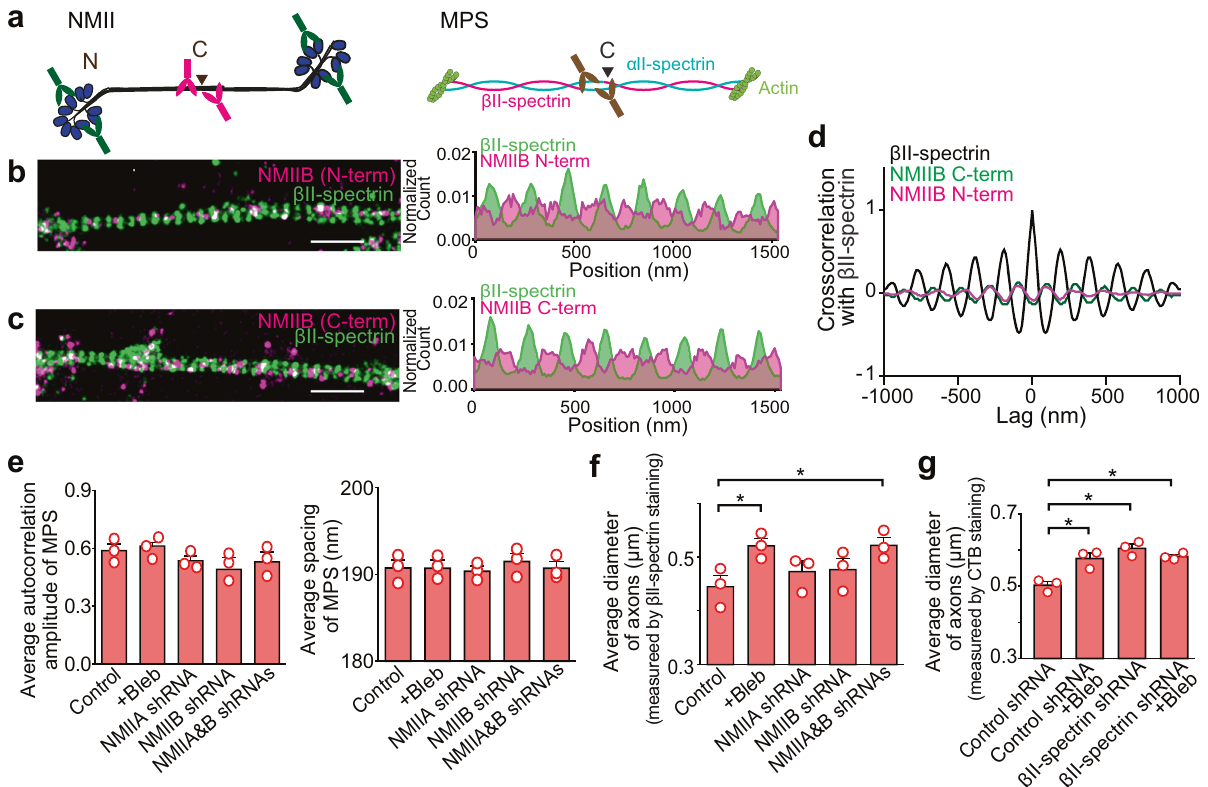
Fig. 3 Non-muscle myosin II (NMII) fi laments bind to the MPS and play a role in radial contractility of axons. a Antibody-binding epitopes at the C- or N-terminus of a NMII bipolar fi lament (left), and the antibody-binding epitope at the C-terminus of β II-spectrin located near the center of the spectrin tetramer. b Left: Two-color STORM image of β II-spectrin (C-terminus, green) and NMIIB (N-terminus, magenta) in axons of cultured hippocampal neurons. Right: Average 1D distributions of β II-spectrin (C-terminus, green) and NMIIB (N-terminus, magenta) signals projected to the longitudinal axon axis from many axon segments. Scale bar: 1 μ m. c Similar to ( b ) but for the C-terminus of NMIIB. d Average 1D cross-correlation between the distributions of β II-spectrin (C-terminus) and NMIIB (N-terminus) (magenta) and between the distributions of β II-spectrin (C-terminus) and NMIIB (C-terminus) (green) along the axons of cultured neurons, derived from 20 – 50 axon segments. The average 1D auto-correlation of β II-spectrin distribution (black) is shown as a reference. e Average 1D autocorrelation amplitudes of β II-spectrin distribution (left) and average periodic spacing of the MPS (right), for axons of untreated neurons, Blebbistatin (Bleb)-treated neurons, and neurons transfected with adenoviruses expressing shRNAs against NMIIA, NMIIB, or both NMIIA and NMIIB heavy chains. f Average diameter of axons (measured by β II spectrin immunostainining) for untreated neurons, Bleb-treated neurons, and neurons treated with shRNAs against NMIIA, NMIIB, or both NMIIA and NMIIB heavy chains. * p < 0.05 (two-sided unpaired student ’ s t-test); p-value s (from left to right): 4.7 × 10 − 2 and 4.7 × 10 − 2 . g Average diameter of axons (measured by CTB staining) for neurons treated with control (scramble) shRNA, neurons treated with control shRNA and Bleb, neurons treated with β II-spectrin shRNA, and neurons treated with β II-spectrin shRNA and Bleb. * p < 0.05 (two-sided unpaired student ’ s t-test); p-value s (from left to right): 3.2 × 10 − 2 , 1.0 × 10 − 2 and 3.3 × 10 − 2 . Data are mean ± s.e.m ( n = 3 biological replicates; 50 – 130 axonal regions per condition). STORM images in b – c are representative examples from three independent experiments with similar results. Source data are provided in the Source Data fi